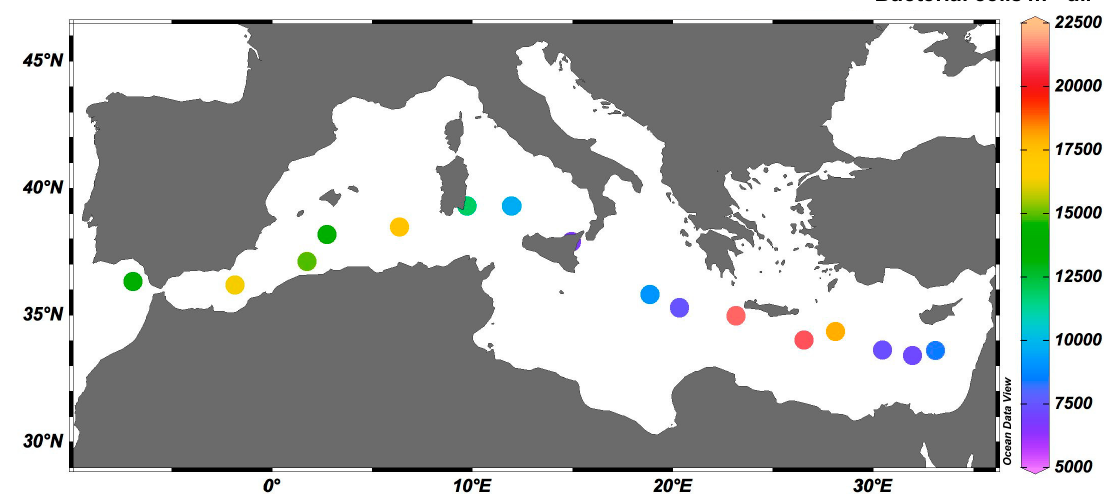
Figure 3. Spatial distribution of airborne bacterial abundance (cells m − 3 air) over the MS during April 2011.